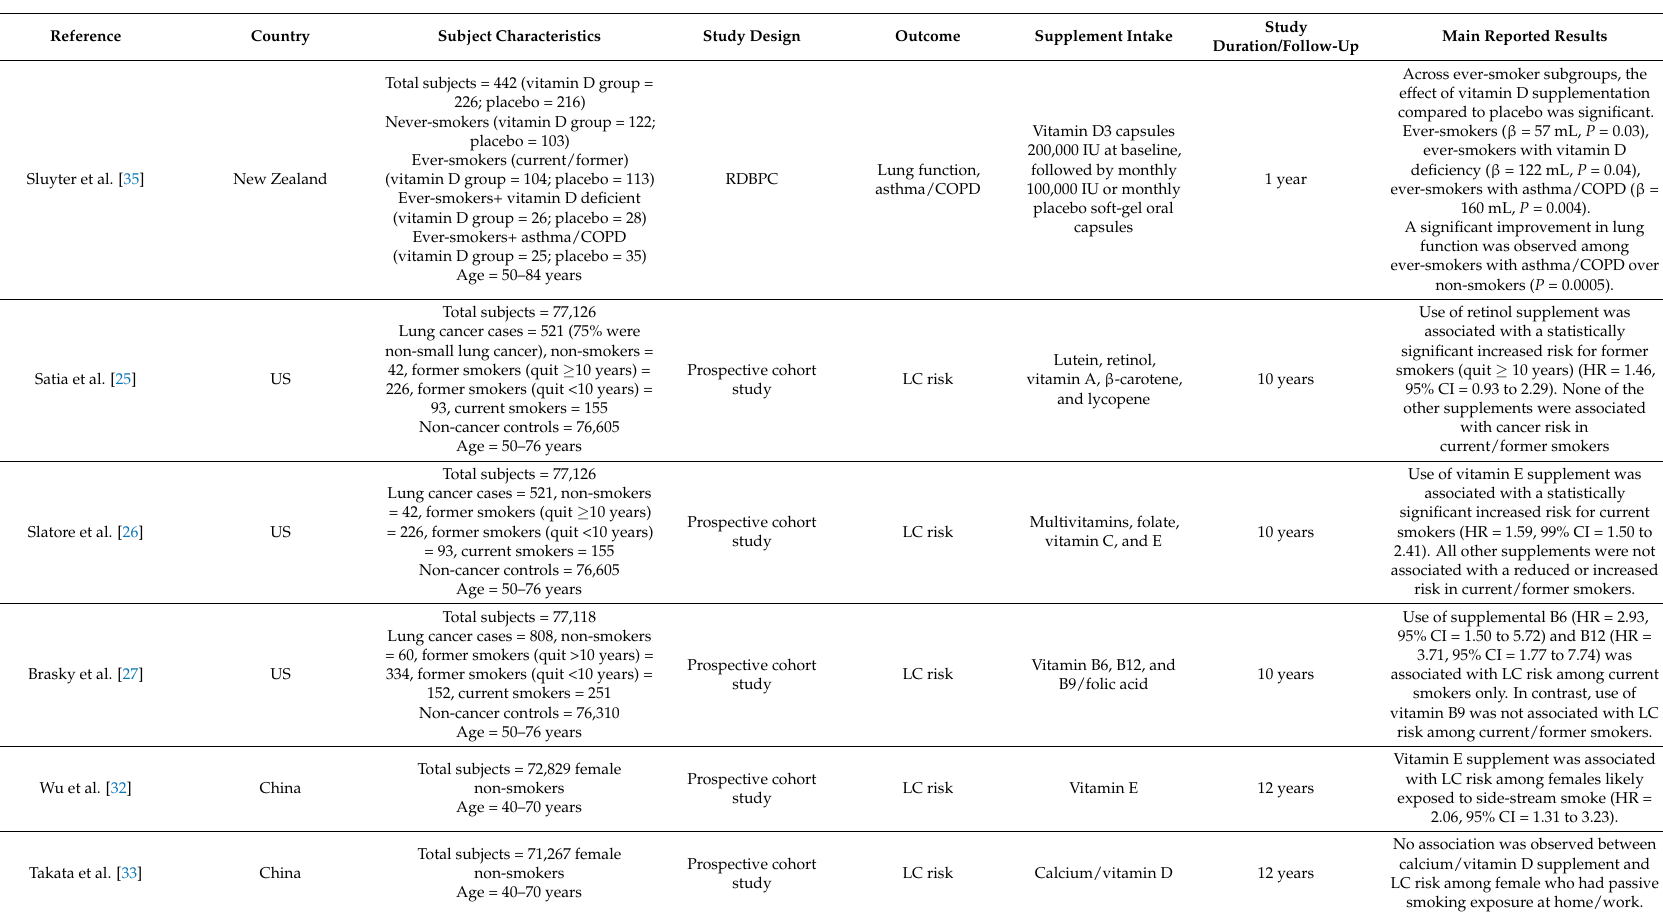
Table 1. Characteristics of studies included in the